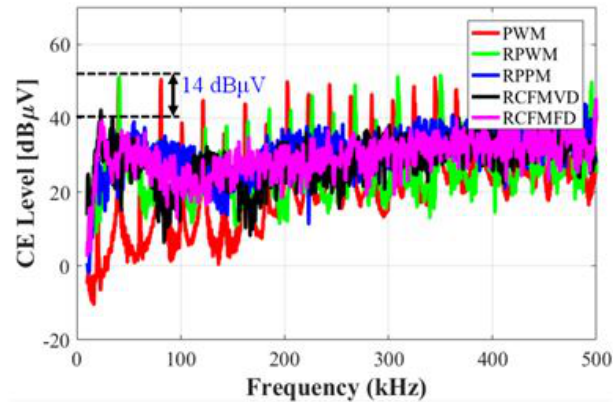
Figure 12. Comparison of the conducted emission for different random schemes for an interleaved buck